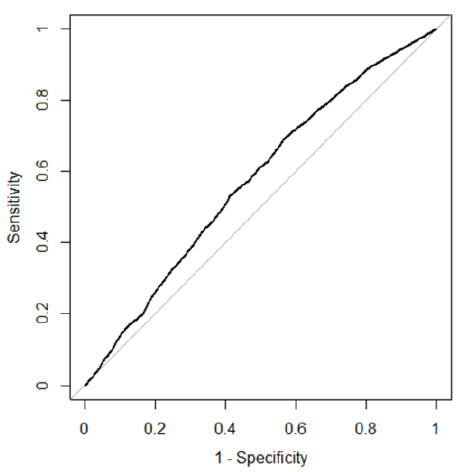
Figure 1. Receiver operating characteristic (ROC) curve for bagging . (Area under the curve (AUC) = 0.575, F-score = 0.520).